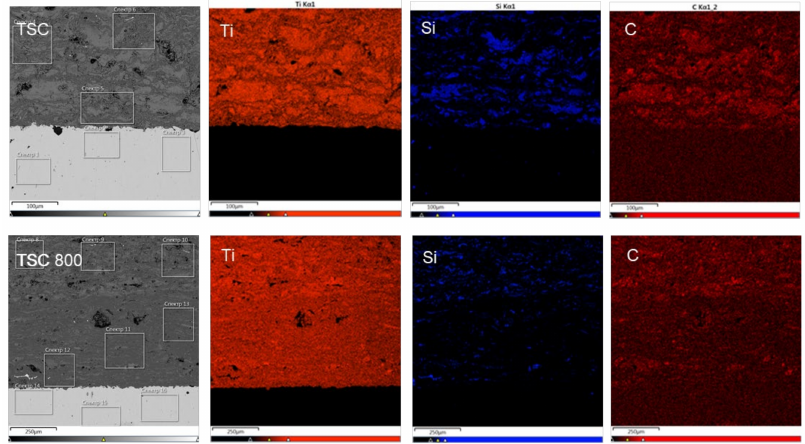
Figure 10. The microstructure of the cross section of coatings with a color images of energy-dispersive spectrometer (EDS) mapping and the result of analysis after annealing at 800 ◦ C.